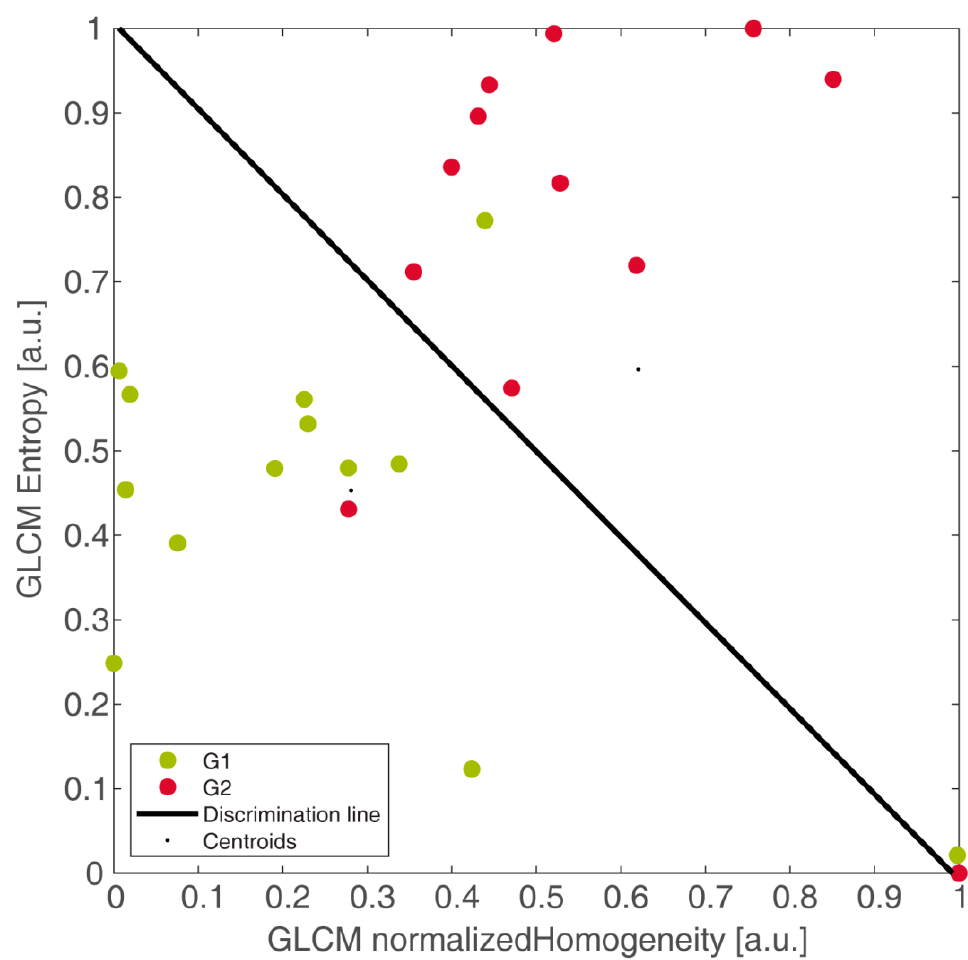
Figure 5. Discrimination of grade 2 (G2, in red) and grade 1 (G1, in green) pancreatic neuroendocrine neoplasia (panNET) patients by second-order normalized homogeneity and entropy, linearly separated by the linear discriminant analysis boundary (in black). Here, patients with grading assessed through histology on the whole excised primary lesion (HS) were well discriminated. This also represents the output of the training stage of model A.